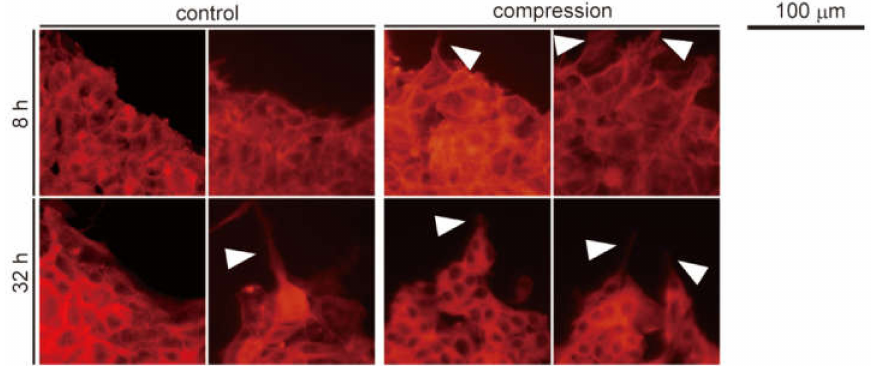
Figure 6. Fluorescent microscopic images of B16F10 cells in the melanoma model stained by rhodamine-phalloidin at each time point in the outer edges of the cell-adhered area. White arrowheads indicate an elongation of F-actin